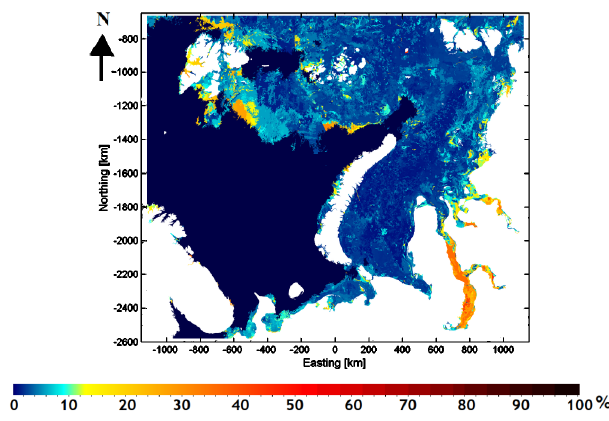
Figure 12. Segment difference ( T ) as a measure of uncertainty of the SIT estimates. This is the segment difference for the 21 February 2017 case. The values of T have been scaled to the range 0–100, based on the variation in T in the training data. The black area is open water.